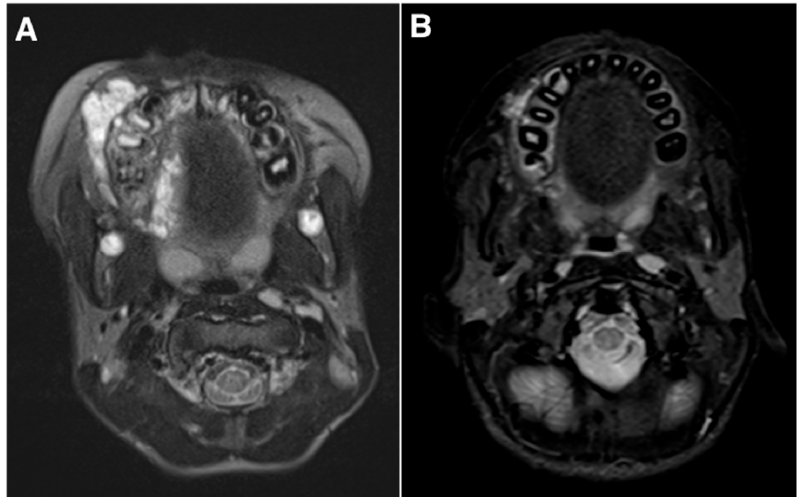
Figure 1. Images from a 32-year-old male with symptomatic venous malformation (VM). ( A ) pre- treatment T2-weighted STIR magnetic resonance imaging (MRI) showing an extensive VM of the right cheek cantered on the upper jaw. ( B ) Post-treatment T2-weighted MRI after two sessions of bleomycin sclerotherapy showing significant volume reduction of the VM (about 70%), with significant discomfort (visual analog scale, 2 versus 5), cosmesis score (2 versus 6) and overall satisfaction (markedly) improvement.